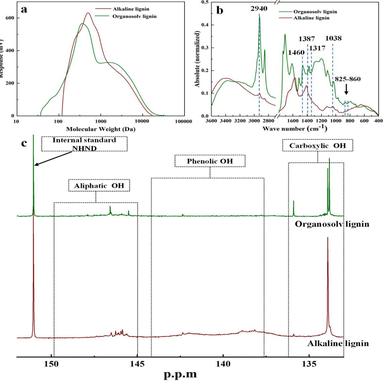
Molecular weight and functional group analysis of organosolv lignin and alkaline lignin. (a) GPC; (b) FTIR; (c) 31P NMR.